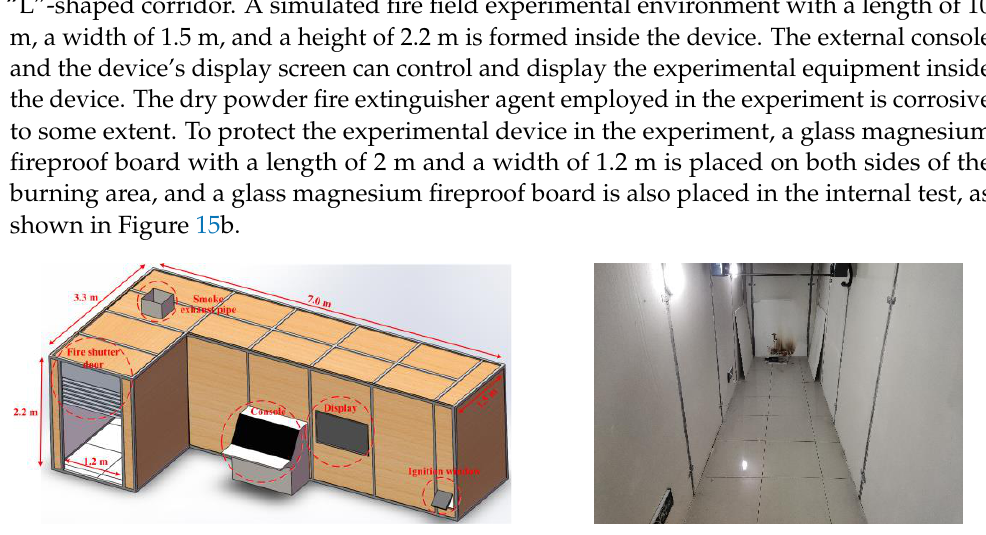
Figure 15. Experimental setup: ( a ) Building fire simulation experimental device. ( b ) Inside the device before the experiment.